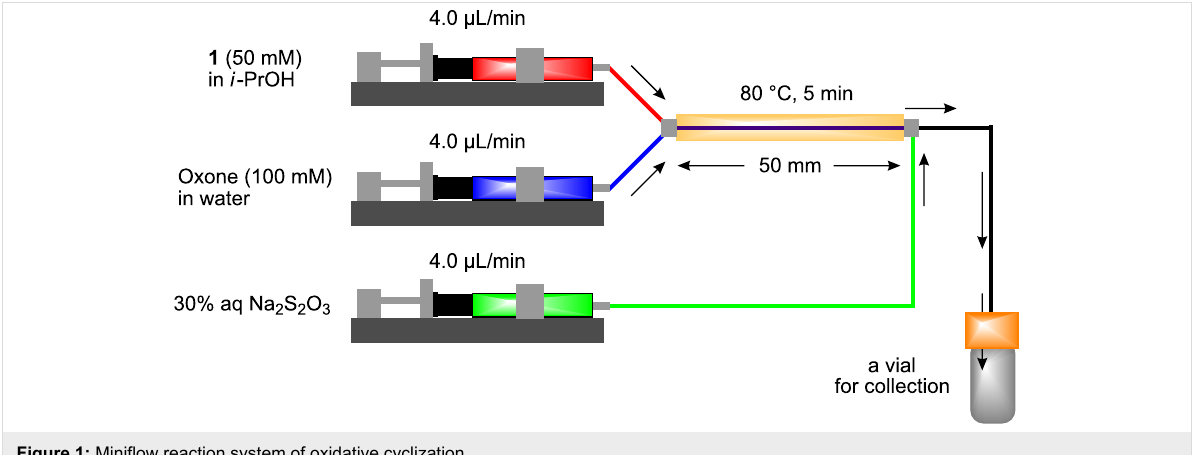
Figure 1: Miniflow reaction system of oxidative cyclization.